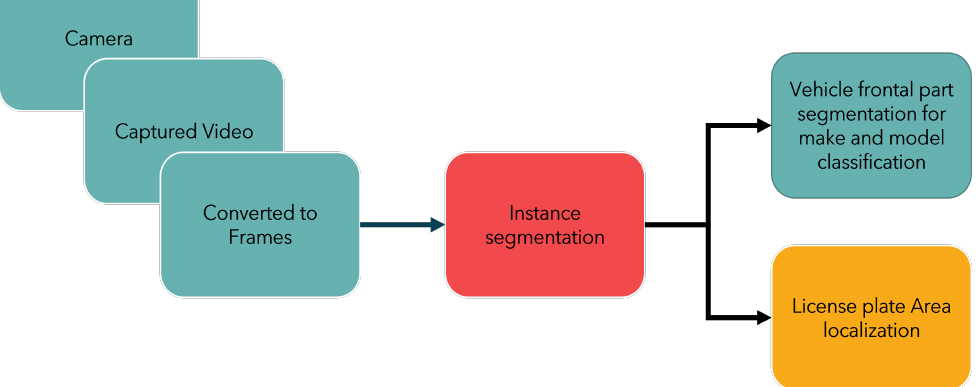
Figure 2. Vehicle instance segmentation technique for license plate localization along with make and model